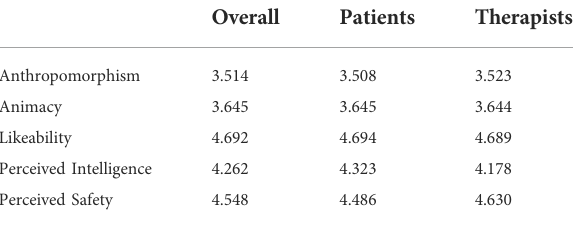
TABLE 2 Results of Godspeed questionnaire: average over a 5-points Likert scale.